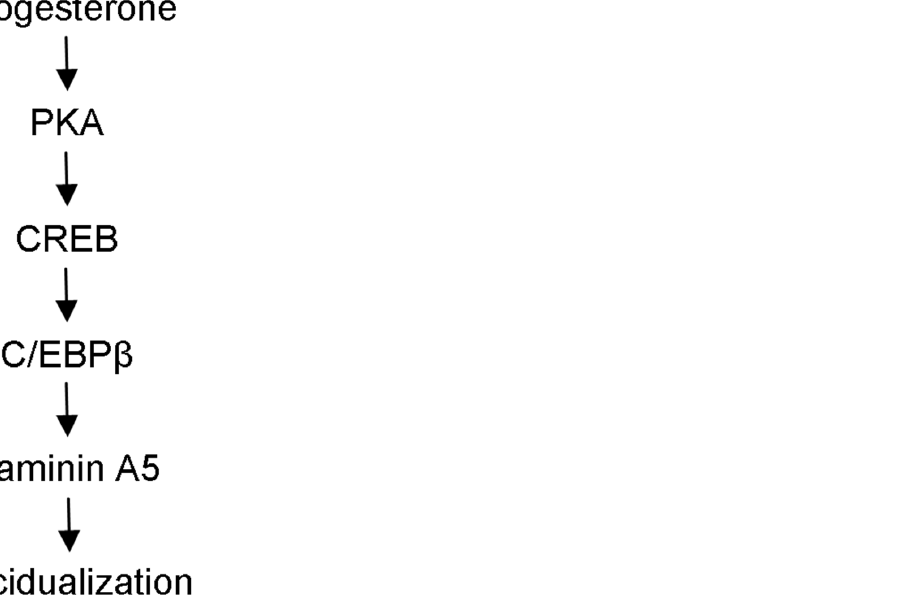
Figure 9. The schematic pathway showing the regulation of laminin A5 on mouse decidualization.